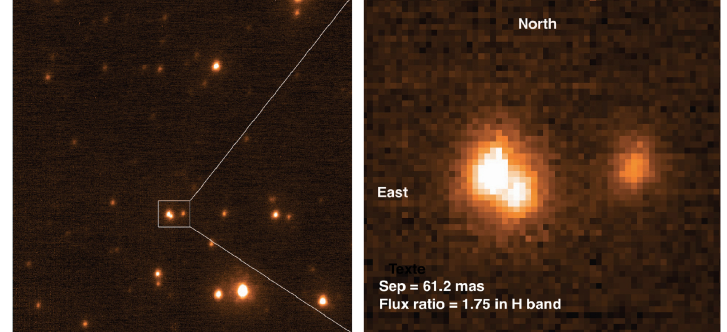
Figure 6. Left KECK H-band image of the source and lens stars in the planetary microlensing event OGLE-2005-BLG-169 (24 × 21 arcsec). Right, a zoom on the target showing the lens on the upper left and the source. They are separated by 61 mas. The extra star on the right was part of the measured blending in the ground-based microlensing light curve. We confirm the initial model of a Neptune mass planet orbiting a K dwarf [63] and improve the parameters of the system to better than 10% [55]. This is the first planetary microlensing where lens and source have been resolved by high angular imaging. Source and lens have also been resolved by HST